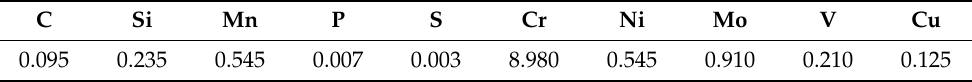
Table 3. Chemical composition (wt %) of the filler metal